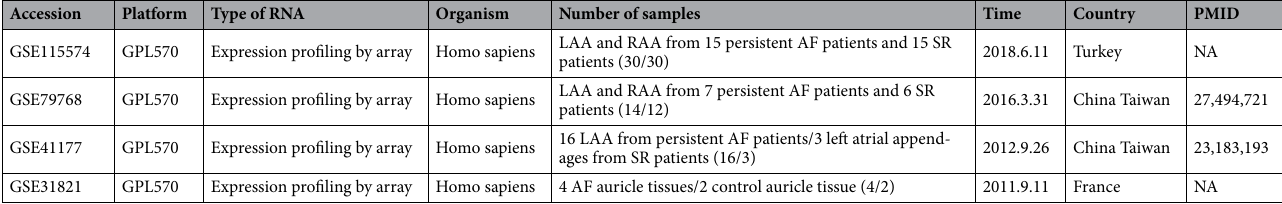
Table 1. Detail information for GEO